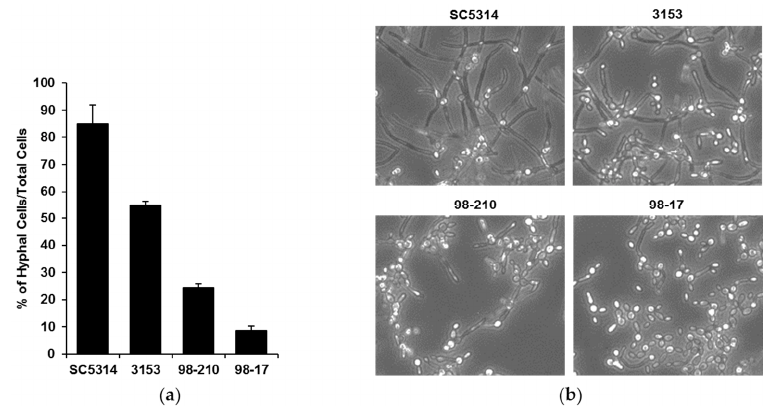
Figure 1. C. albicans clinical strains exhibit differing filamentation. ( a ) Filamentation of the clinical isolates was determined by incubating planktonic cells for 4 h in RPMI with 2% FBS at 37 °C in microfluidic devices and counting the cells producing hyphae as a percentage of total cells, SD shown. ( b ) Light microscopy images of clinical strains after 4 h of hyphal-inducing conditions (RPMI with 2% FBS at 37 °C, 20×).